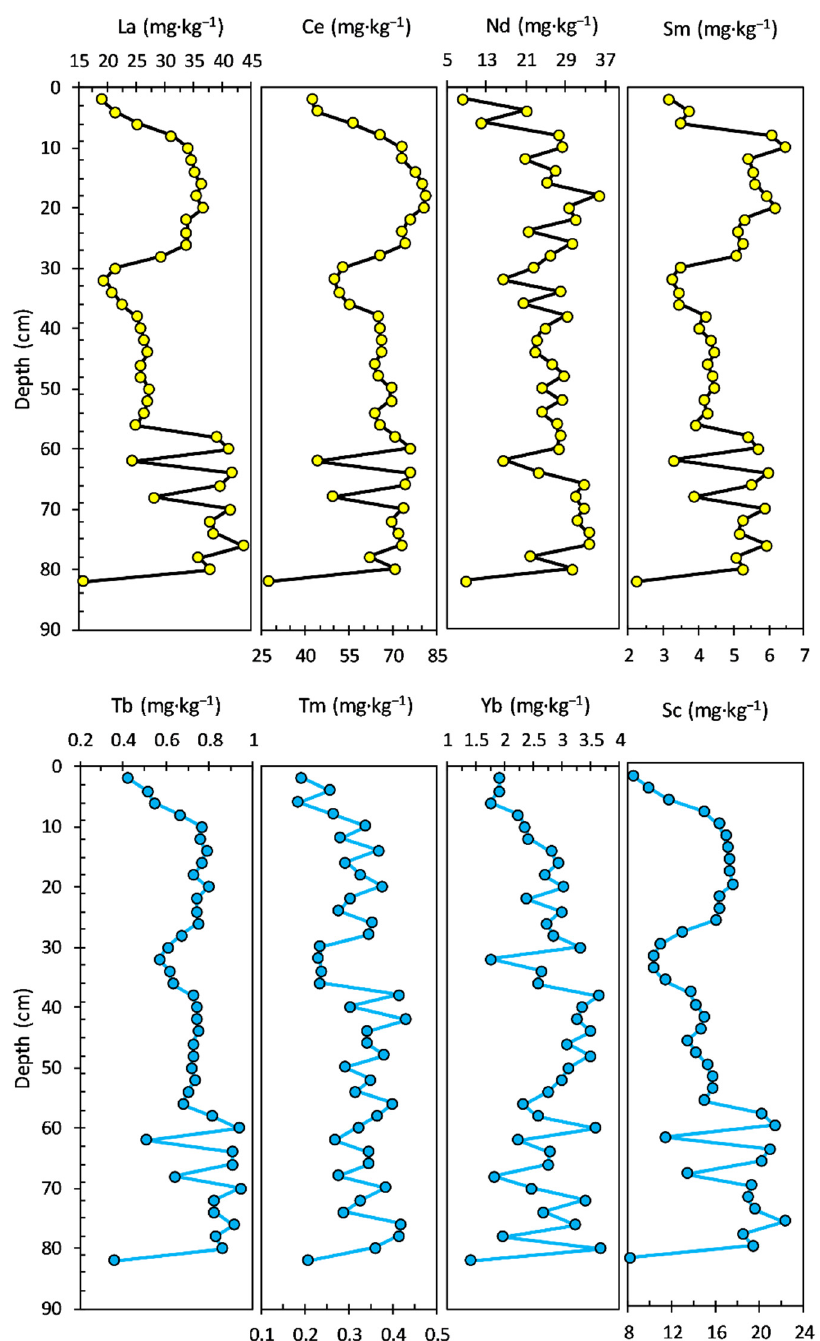
Figure 8. Vertical distribution of geochemical light rare earth elements—LREE (La, Ce, Nd, Sm) and heavy rare earth elements—HREE (Tb, Tm, Yb, Sc) in the Caineni Lake sediment core (82 cm